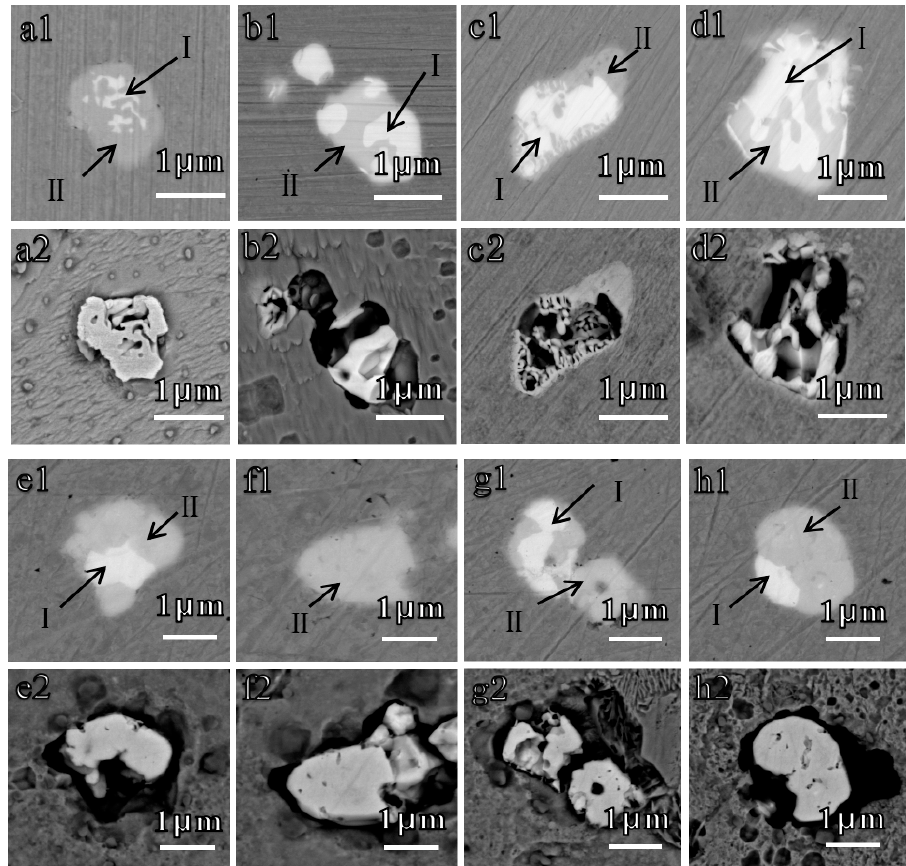
Figure 8. In-situ dissolution behaviors of inclusions in ( a – d ) Al deoxidized steel and ( e – h ) Ti / Zr deoxidized steel after immersion in 0.5 wt.% NaCl for 10 min. ( a1 – h1 ) Before corrosion, ( a2 – h2 ) after corrosion. The inclusions marked I are M-O x S y (M-S x ) and II are M-O x , which are the same as those in Figures 6 and 7.